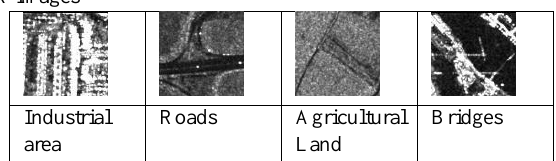
Table 1: Example of land use land cover categories of